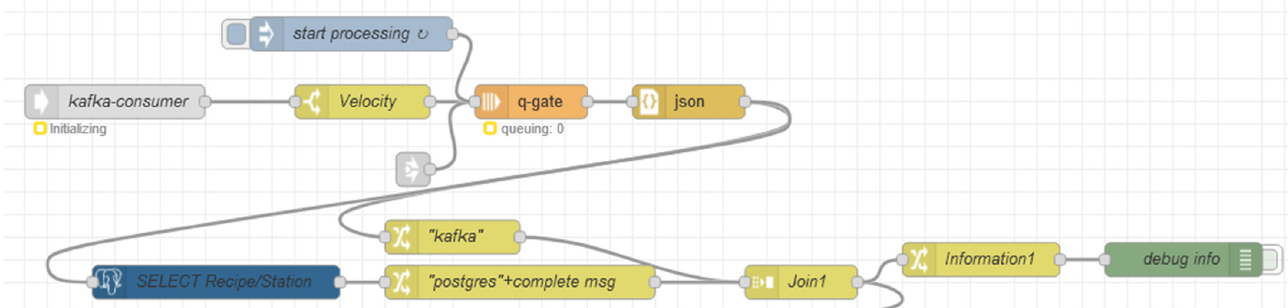
Figure 12. Kafka communication using the “kafka-consumer” node.